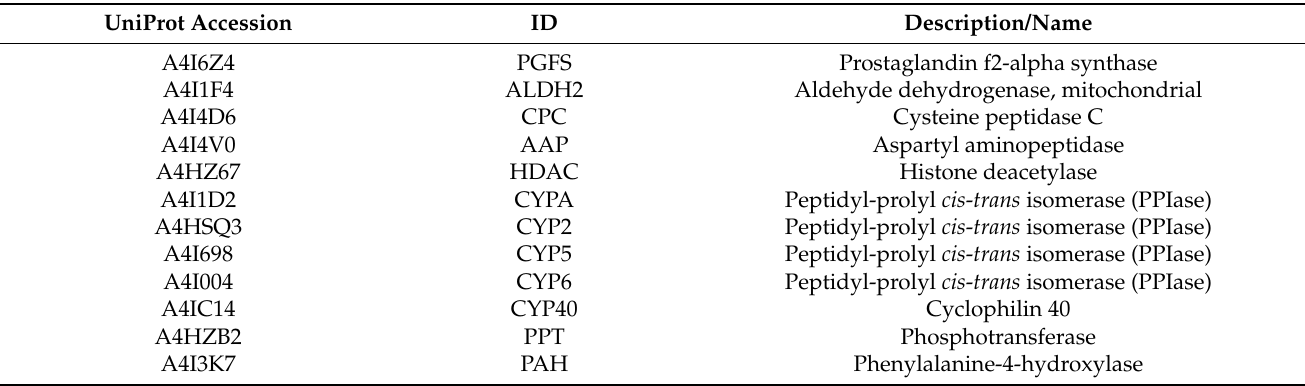
Table 3. Potential targets of compound 33 in L. infantum